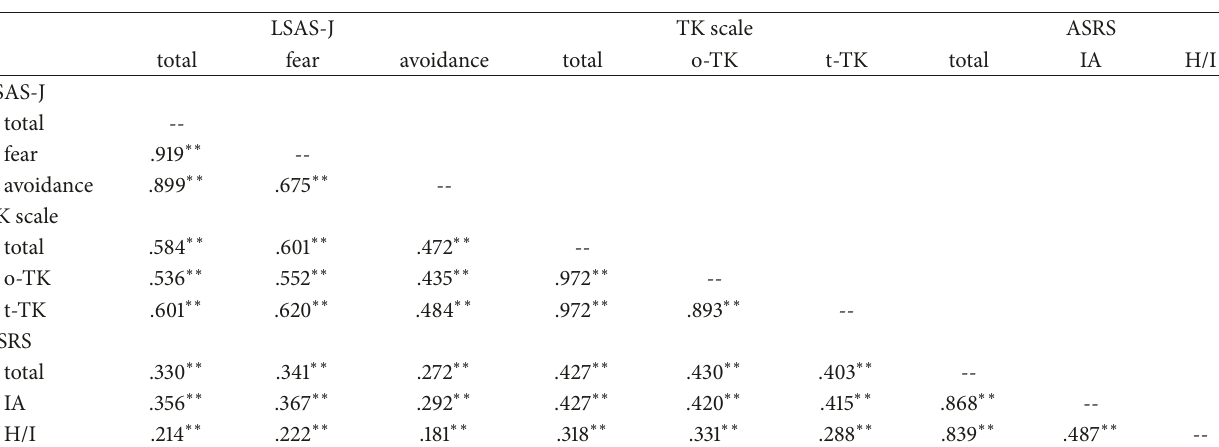
Table 2: Correlations among